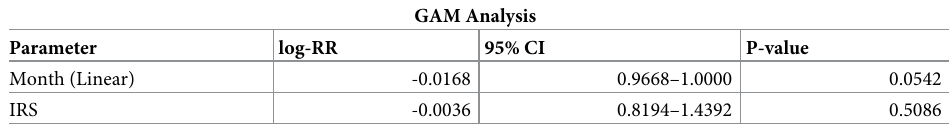
Table 2. Generalised Additive Model Analysis result of P . argentipes abundance data from April 2016 to Decem- ber